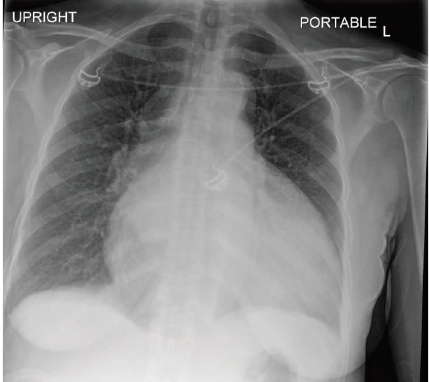
Figure 1: Upright AP CXR obtained on admission shows markedly enlarged cardiac silhouette, mild pulmonary vascular congestion, and bibasilar subsegmental atelectasis.